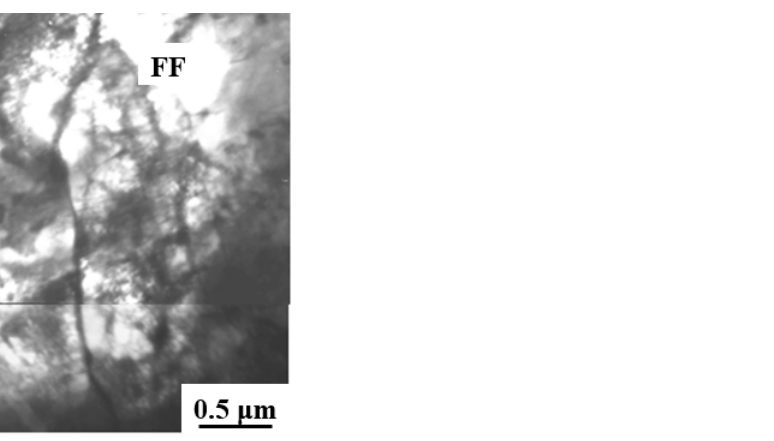
Figure 10. Condition after long-term operation (260 thousand hours) without destruction. Zone of localized deformation. Ferrite-pearlite mixture (DP—destroyed pearlite, FF—fragmented ferrite). Transmission electron microscopy.